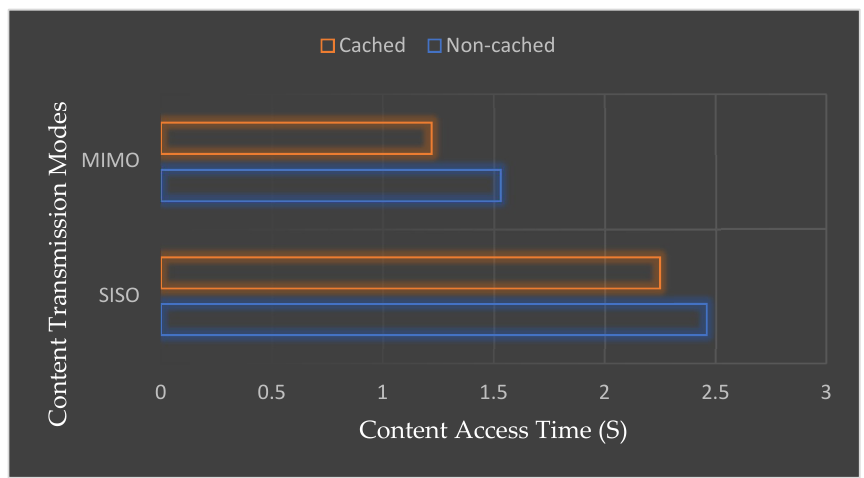
Figure 14. Performance of caching in the LTE network.